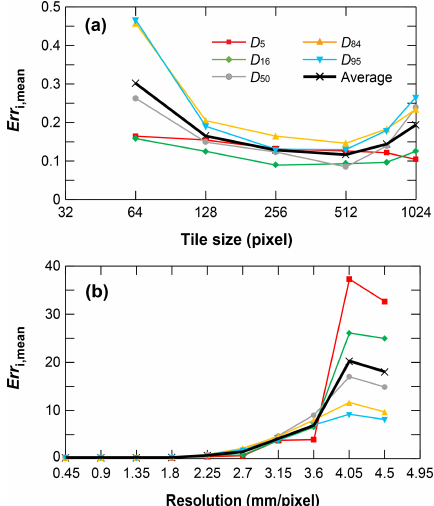
Figure 8. Prediction accuracy of different grain percentiles for (a) different image tile size and (b) different image